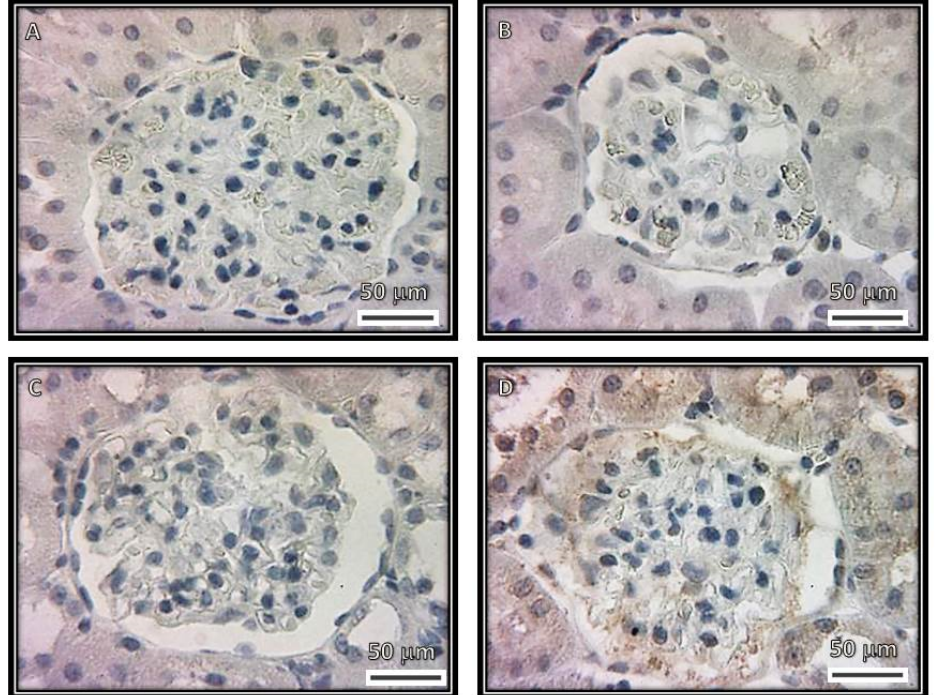
Figure 10. Immunohistochemistry of representative rat renal cortexes for the 5-LOX antibody. The images show glomeruli from ( A ) control, ( B ) kidneys from rats that were injected with saline solution and ( C ) kidneys from rats that received serum from healthy subjects. The images in these three panels show negative stains. ( D ) Kidneys from rats that received serum from patients having collapsing glomerulopathy. In this panel, there is a positive stain.